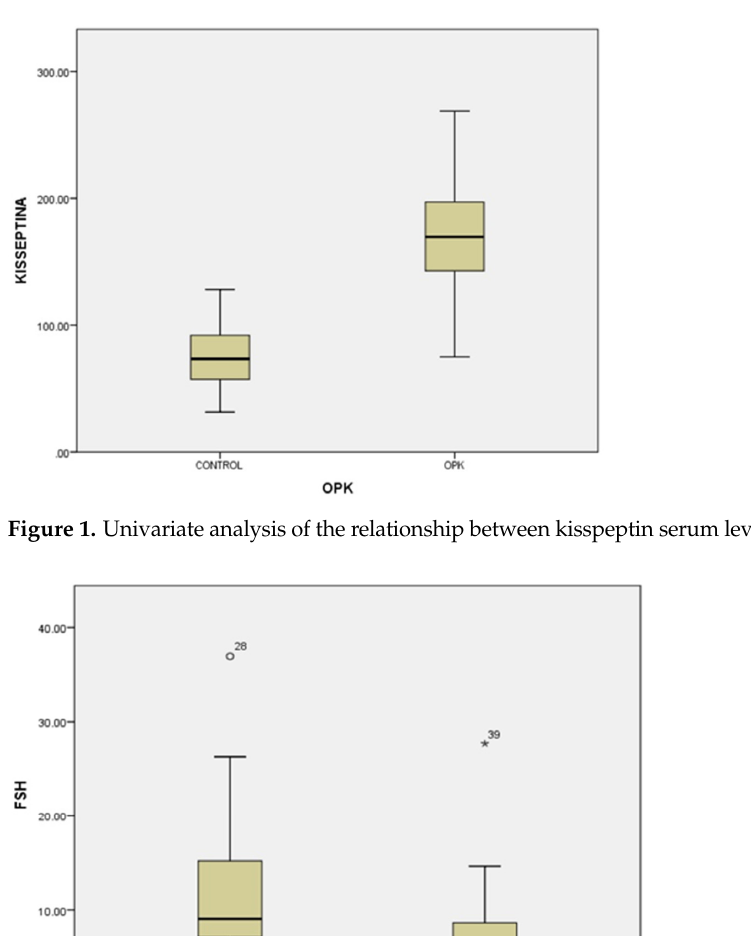
Figure 4. Univariate analysis between LH serum levels and PCOS ( p < 0.001). Circles represent high potential outliers and the stars represent high extreme values 4. Discussion The recent discovery of KISS1/KISS1R and its effects on upregulating GnRH has cre- ated a new pathway for further investigations considering patients with PCOS. New stud- ies have brought clear evidence about the presence of kisspeptin at the ovarian level and the way it is involved in the ovulation process and sex hormone regulation. PCOS is a heterogeneous syndrome; therefore, it is possible that not all patients share the same en- docrine disturbances and hormonal alterations [14]. Neurons responsible for the secretion of kisspeptin are located mainly in two areas: the hypothalamic arcuate nucleus (ARC) and the preoptic area. Steroid sex hormone con- centrations are responsible for the kisspeptin modulation of GnRH secretion. Studies per- formed on laboratory animal models have proven that kisspeptin neurons modulate the